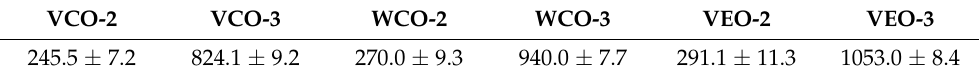
Table 2. Average results of viscosity values of the O/W emulsions measured @20 ◦ C, in